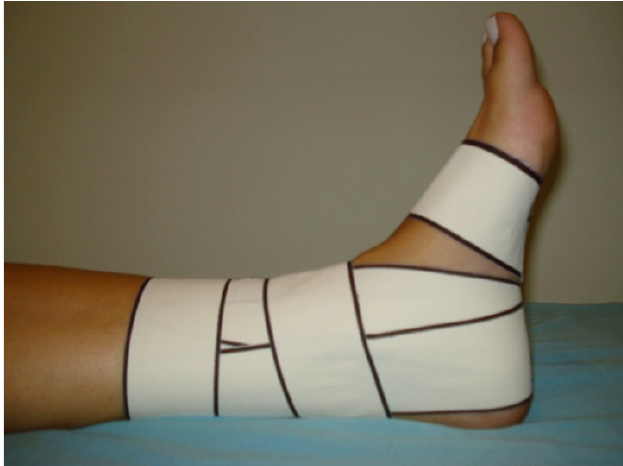
Figure 2. Technique used for taping application (medial view).